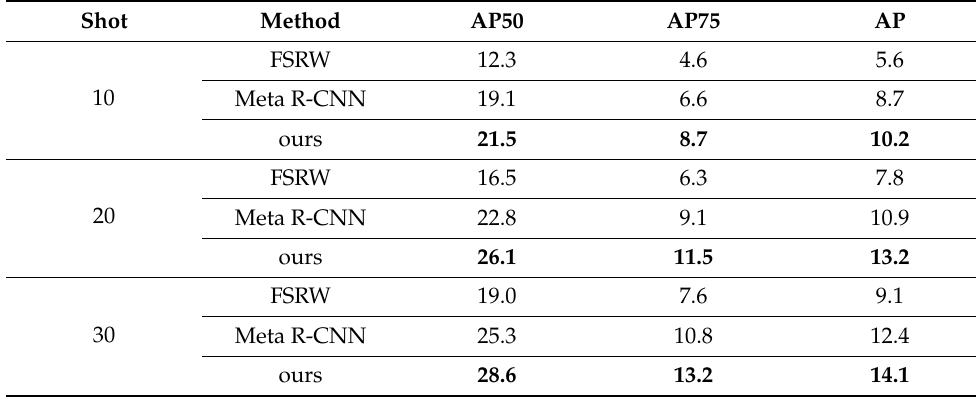
Table 5. The averaged APs of the novel classes on the COCO dataset.